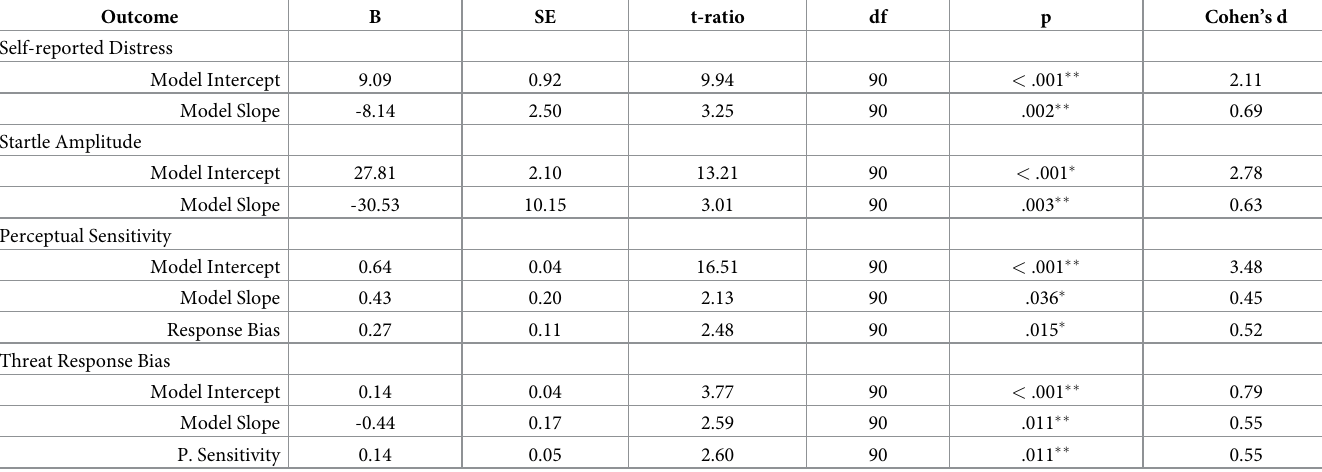
Table 3. Changes in Extent of Recent Marathon-related Coverage Predicts Distress, Startle Reactivity, Perceptual Sensitivity, and Shooting Behavior. Outcome